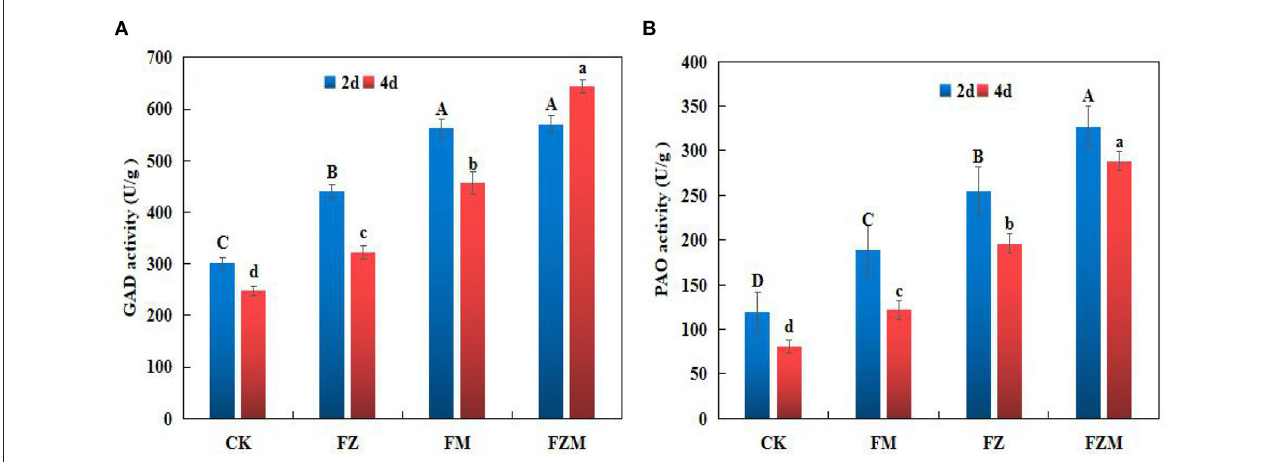
FIGURE 5 | (A) Glutamate decarboxylase (GAD) and (B) polyamine oxidase (PAO) activity in germinating adzuki beans. Different upper and lower case letters indicate significant differences between the 2 and 4 days germination treatments ( p < 0.05). CK: Control treatment (31 ◦ C for 4 d); FM: 2 mg/ml MSG treatment; FZ: 15h